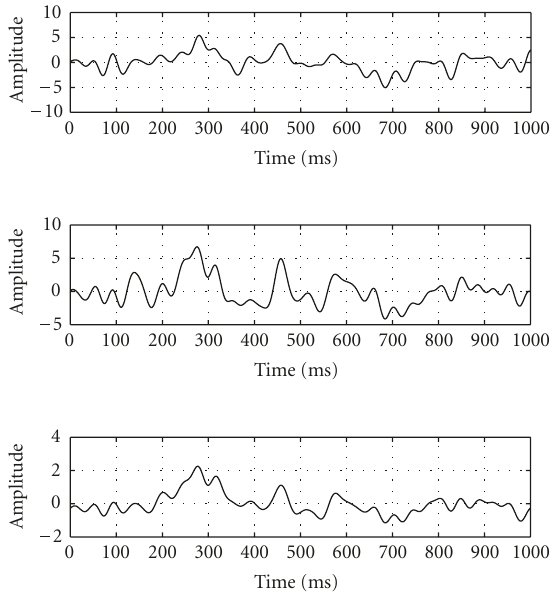
Figure 13: The top figure shows the output obtained by normal Infomax while the middle figure shows the CBSS output and the bottom figure shows the reference signal for a schizophrenic patient.